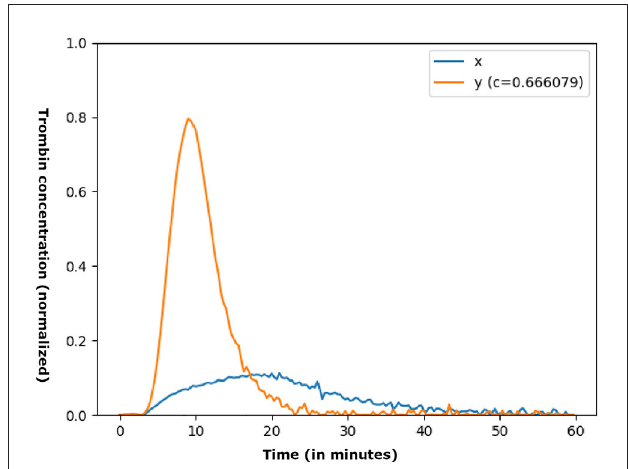
FIGURE4 Example of { x , c , y } data. The abscissa represents the measurement time while the ordinate illustrates the concentration of thrombin (normalized). The dose is expressed over the whole [0,1], c ≈ 0.67 corresponds to the injection of a concentration of 83.62% of therapeutic factor